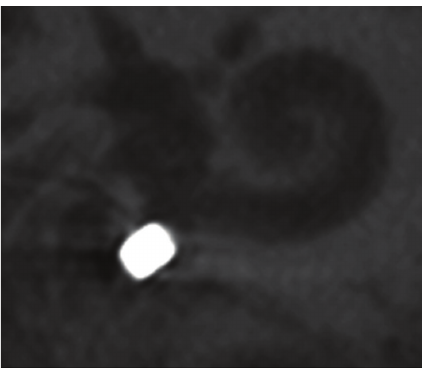
Figure 3: Type III coupling—FMT in contact to RW, not rectangu- lar.